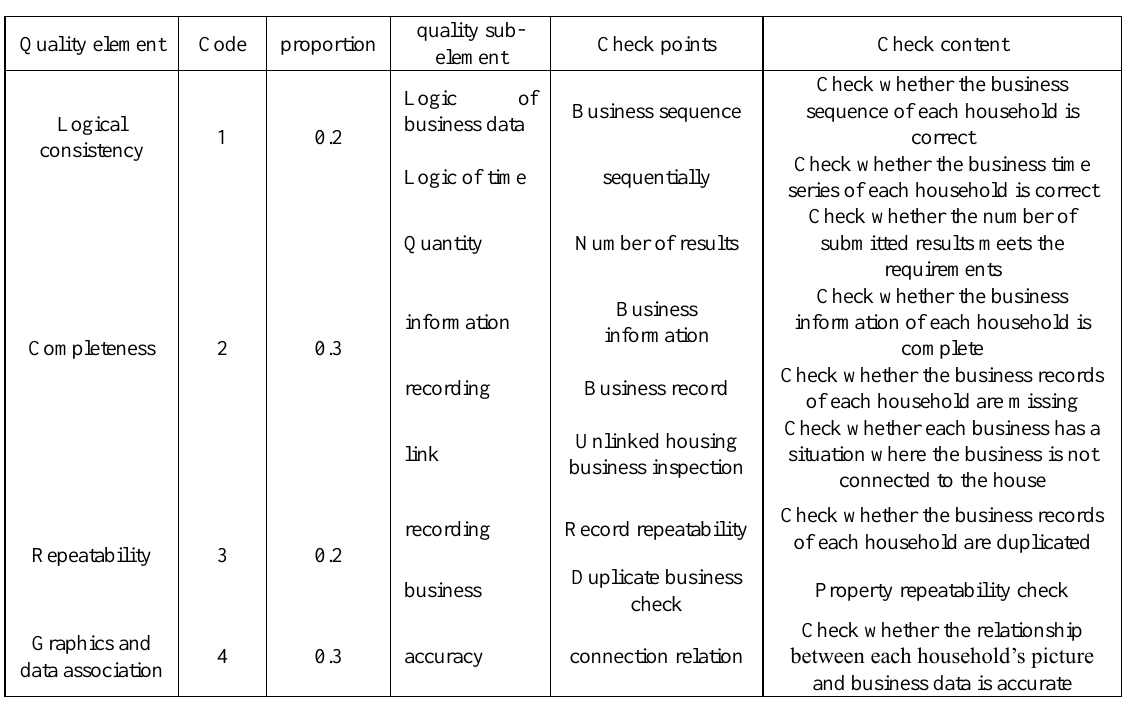
Table 5 . Contents and methods of checking the results of group building.